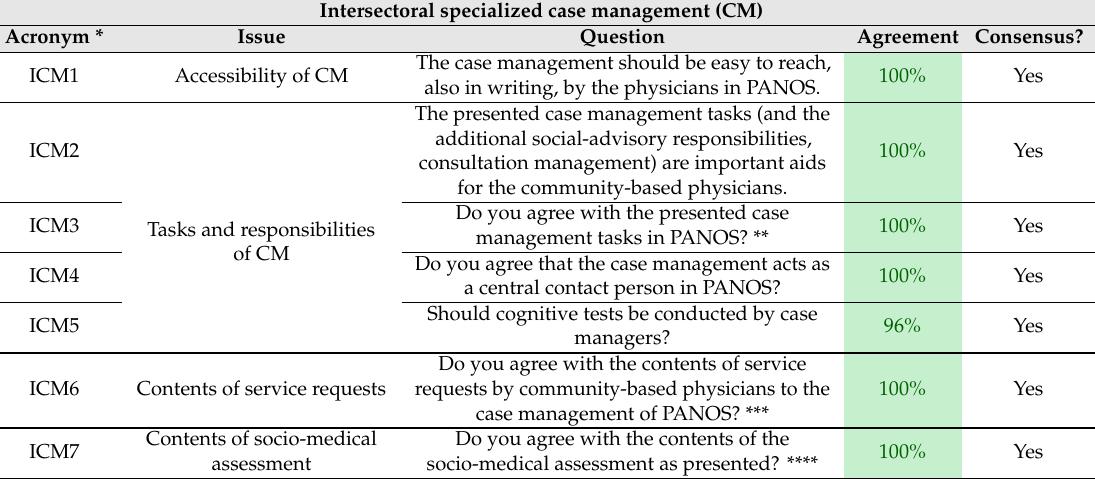
Table 6. Results of TED voting– intersectoral specialized case management. Intersectoral specialized case management